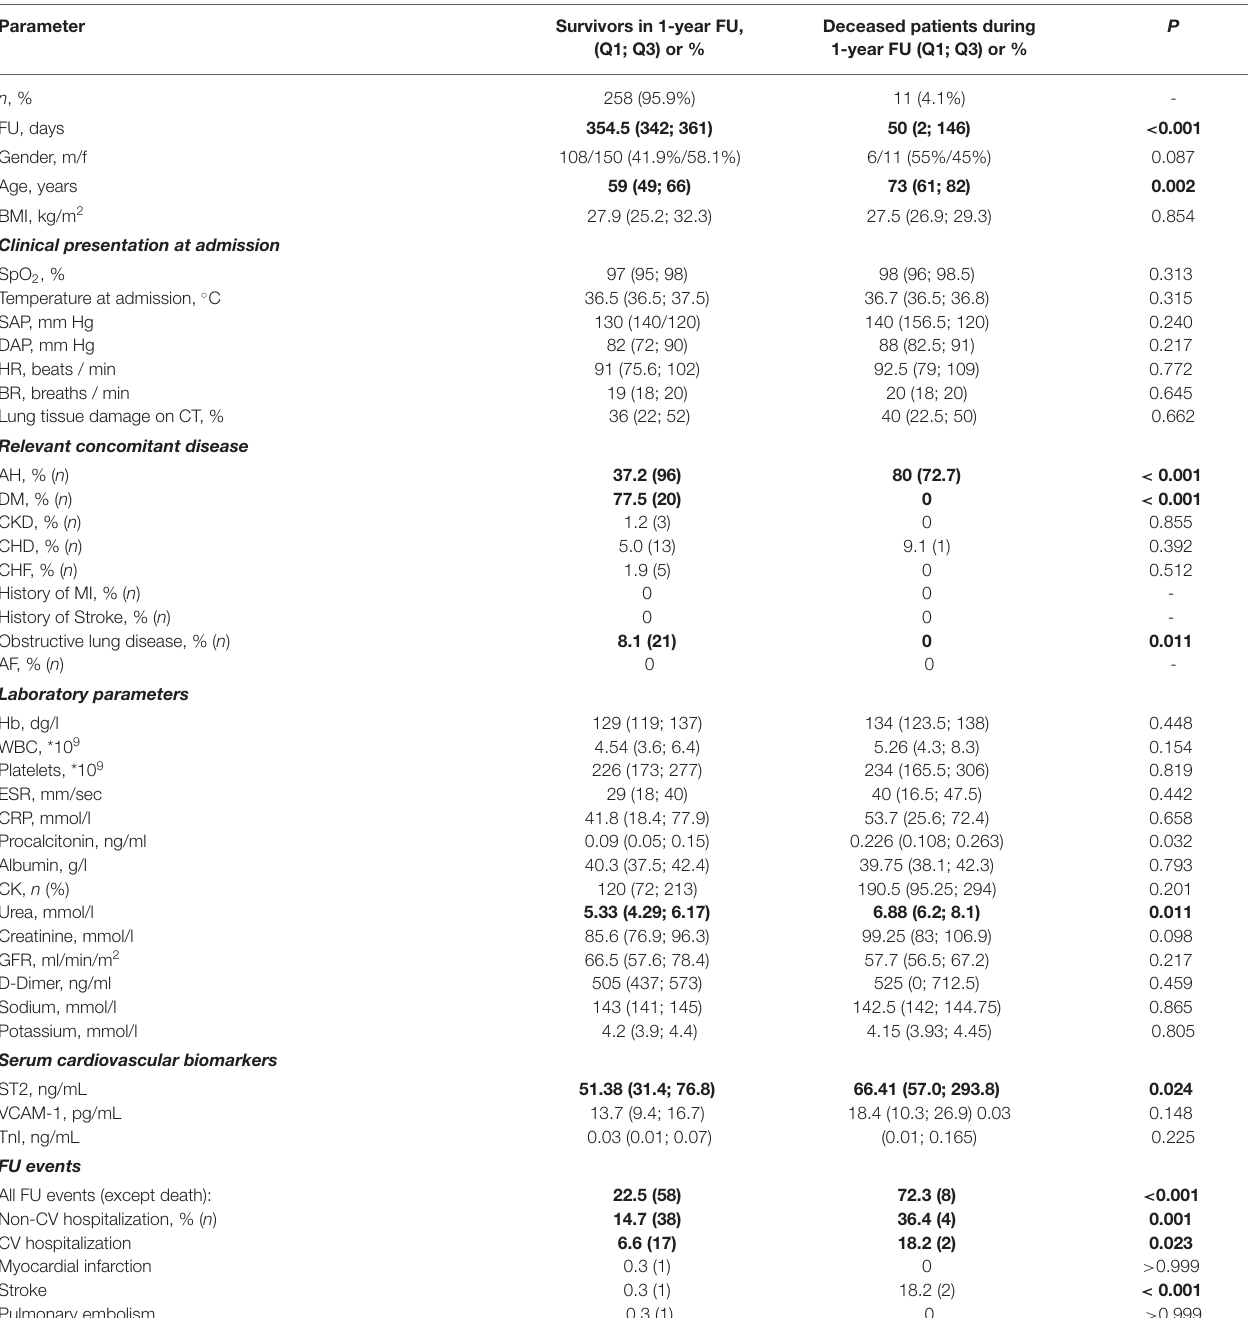
TABLE 4 | Comparison of deceased and surviving patients at 1-year FU.